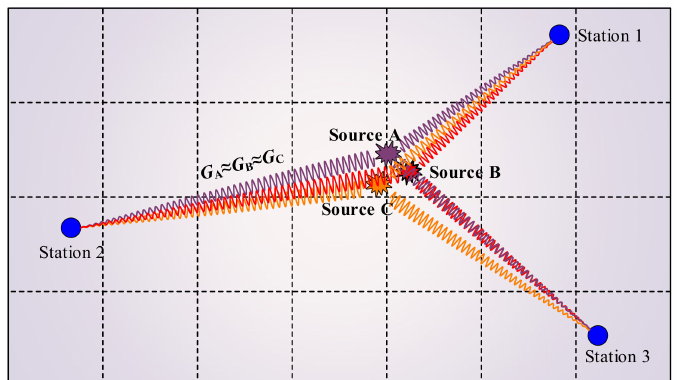
Figure 3. Schematic diagram of relative MTI method. The G A , G B, and G C represent similar Green’s functions among the source clusters. It is noticed that the stations in the coal mine move along with the